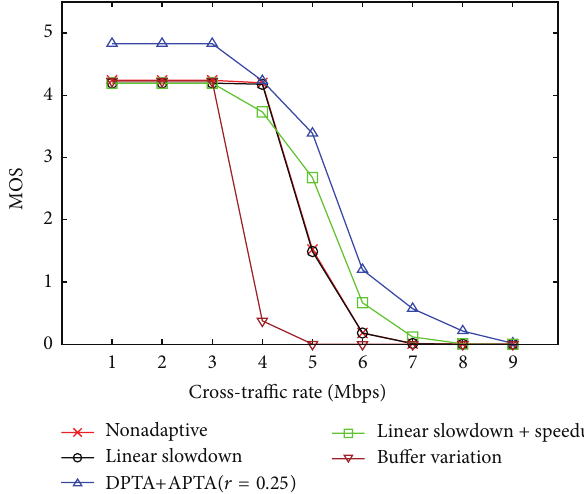
Figure 6: Overall QoEs of different playout systems.